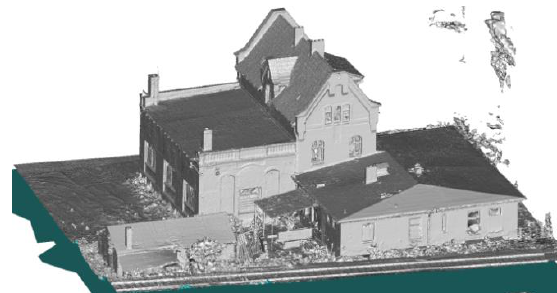
Figure 15. Meshed surface of the building, generated from UAV images, solely. A precise, homogeneous and complete reconstruction could be achieved with the well distributed images of our flight planning and execution concept.